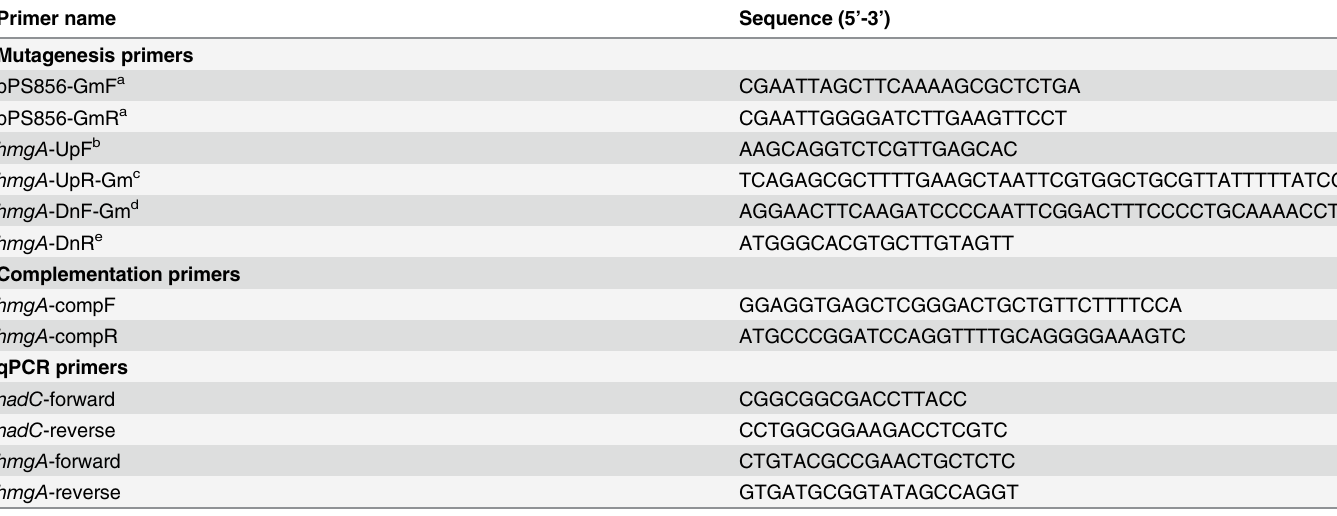
Table 2. Oligonucleotide primers used in this